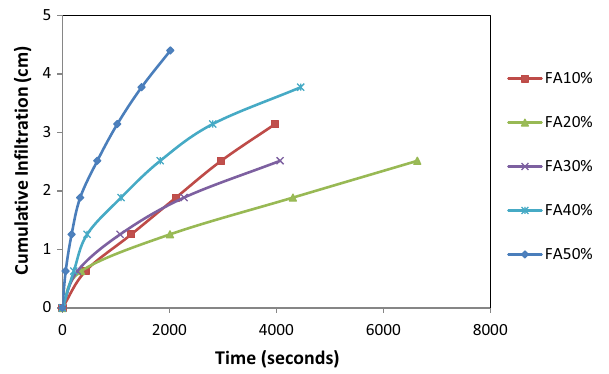
Fig. 3 Cumulative infiltration versus time for varying fly ash at 2% moisture content